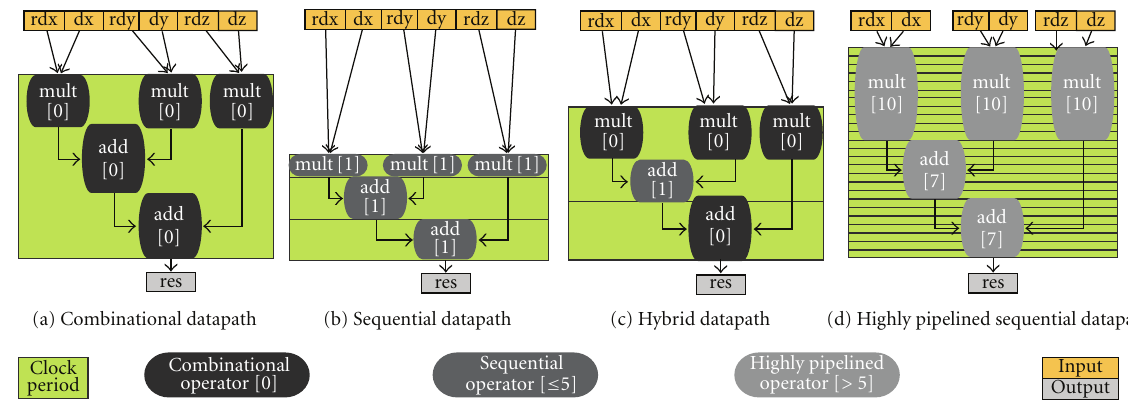
Figure 3: Di ff erent types of a DFG presented for a UDCI candidate shown in Listing